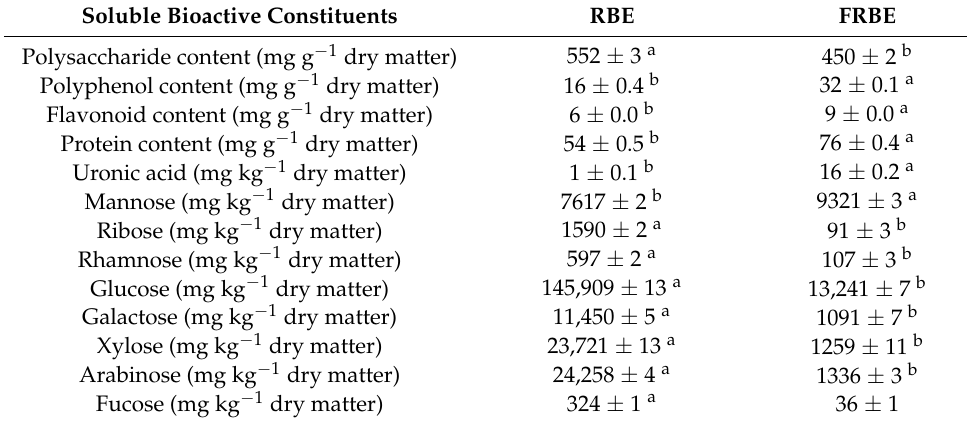
Table 1. Bioactive constituent contents in water-soluble rice bran extracts. Soluble Bioactive